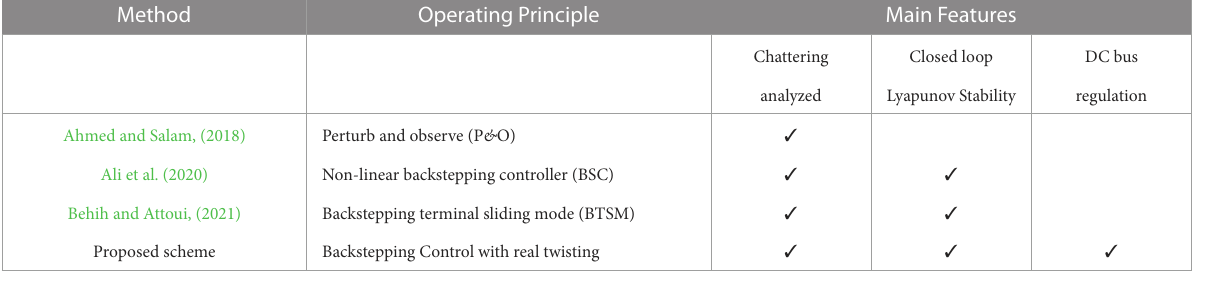
TABLE1 ComparisonofcontrolschemesofPVsystem.